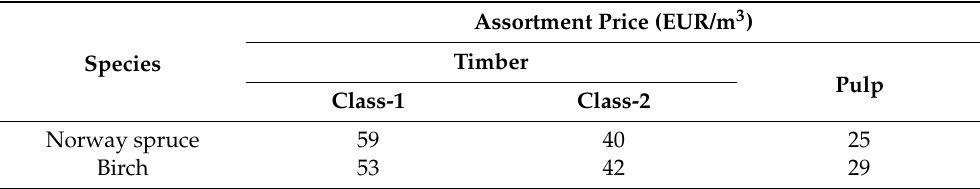
Table 1. Price for the assortment of Norway spruce and birch.